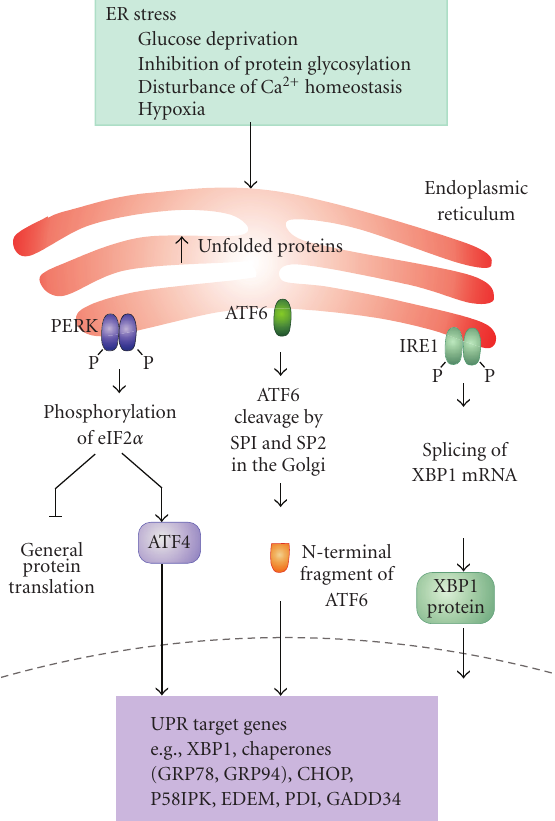
Figure 2: ER stress and the unfolded protein response. Stress to the ER stimulates the activation of the three endoplasmic reticulum (ER) stress receptors, PKR-like ER kinase (PERK), activating transcription factor 6 (ATF6) and inositol-requiring enzyme 1 (Ire1) that are involved in the unfolded protein response (UPR). PERK phosphorylates eukaryotic initiation factor 2 (eIF2 α ) which inhibits general protein translation, allowing eIF2 α -independent translation of ATF4, which activates transcription of chaperones such as GRP78. ATF6 undergoes specific proteolysis in the Golgi apparatus which leads to activation. One of the ATF6 target genes is XBP1. IRE1 catalyzes the alternative splicing of XBP1 mRNA leading to expression of the active XBP1 transcription factor. Together the three arms of the UPR block protein translation, increase chaperone expression and enhance ER-associated protein degradative